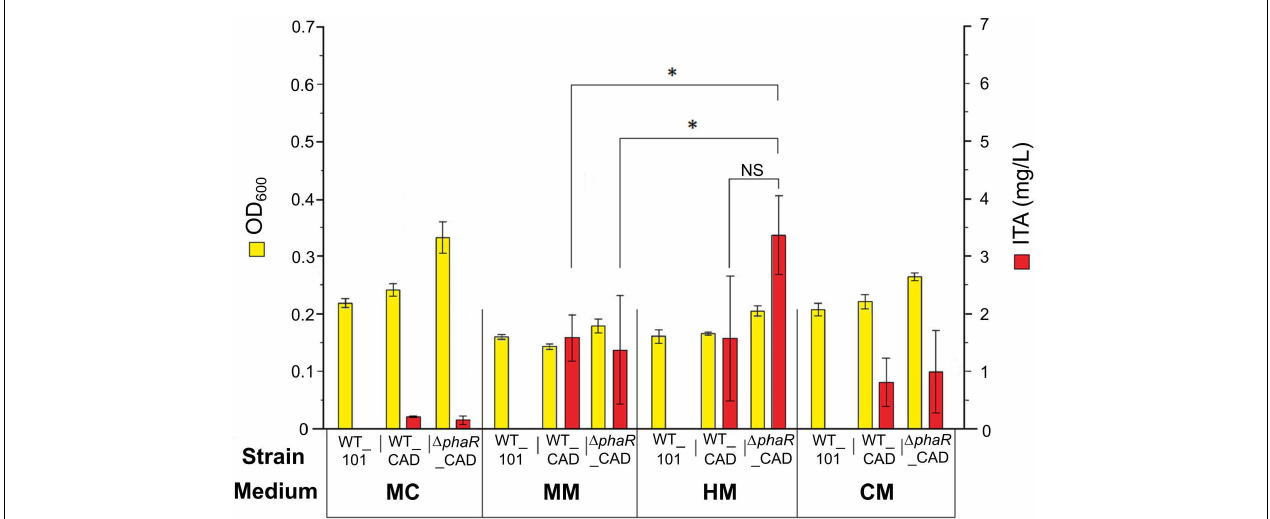
FIGURE 2 | Comparison of cell biomass concentration (OD 600 ) and ITA production between strains grown in different media. 5 mM sodium acetate was used as the carbon source. Samples were taken at the end of the cultivation period (day 8) after acetate was completely consumed. Low PHB content ( < 1%) was observed in all strains (data not shown). Asterisk ( ∗ ) denotes significant difference (Student’s t -test, p < 0.05), whereas NS denotes no statistically significant difference. Error bars represent one standard